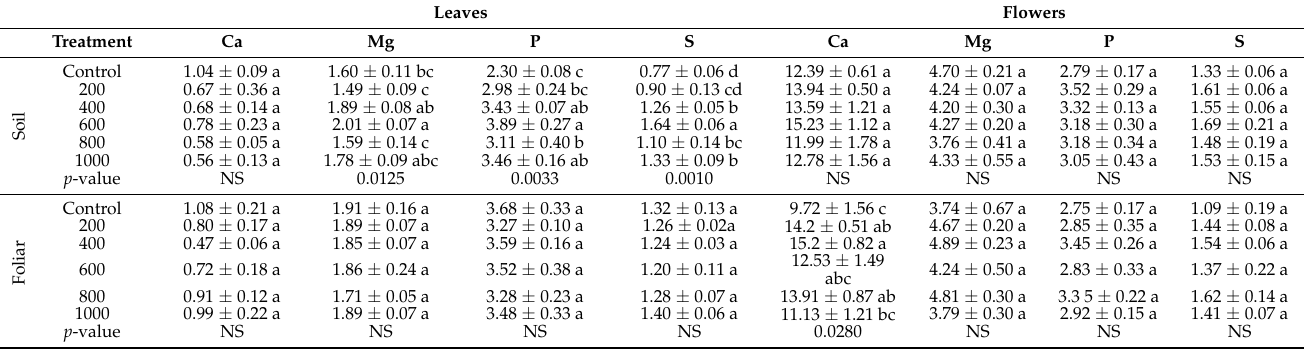
Table 1. Effect of the application of SiO 2 NPs on the concentration of macronutrients in leaves and flowers. Leaves Flowers Treatment